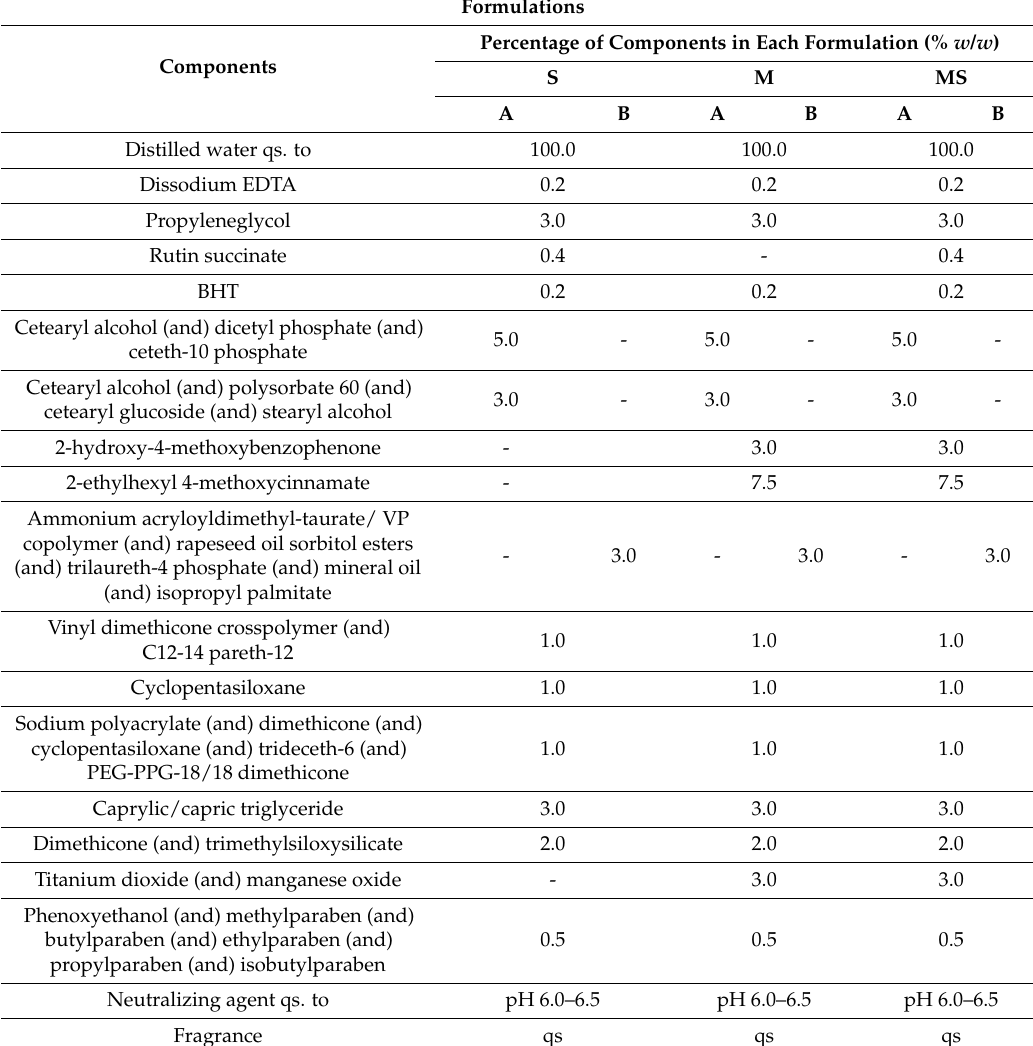
Table 1. Composition of the formulations under